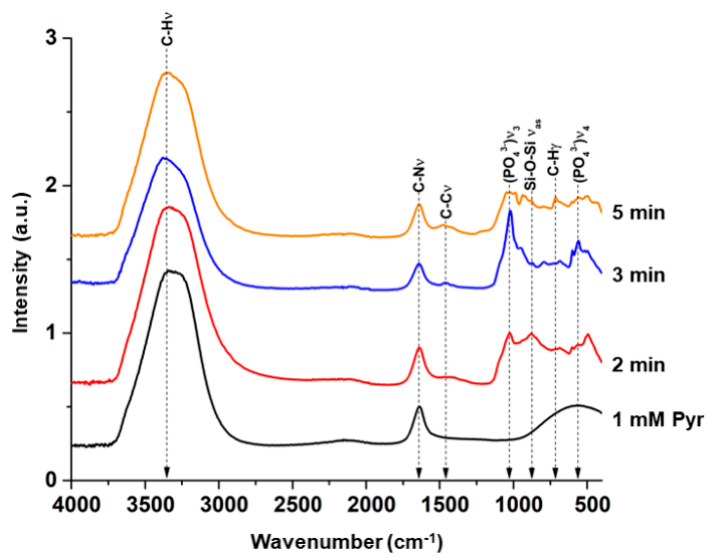
Figure 10. Infrared spectra of 1 nM pyridine on the supports doped for 2, 3 and 5 min in a 10 mM AgNO 3 solution at 3.3 V, and of 1 mM pyridine (black).